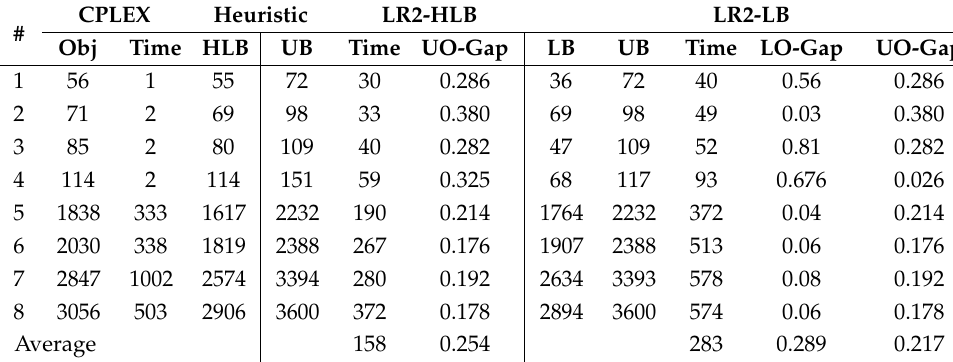
Table 8. Computational results to compare CPLEX and LR2 for small size instances.